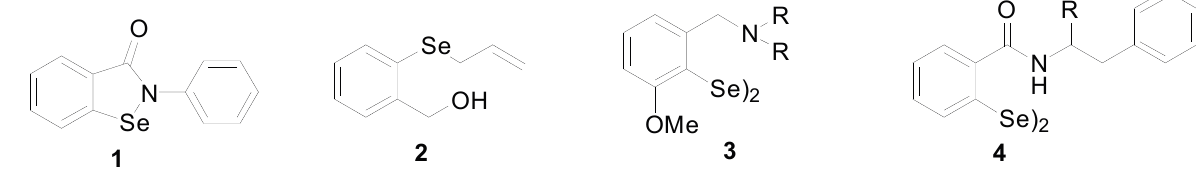
Figure 1. Ebselen ( 1 ) and organoselenium compounds 2 – 4 with a heteroatom in close